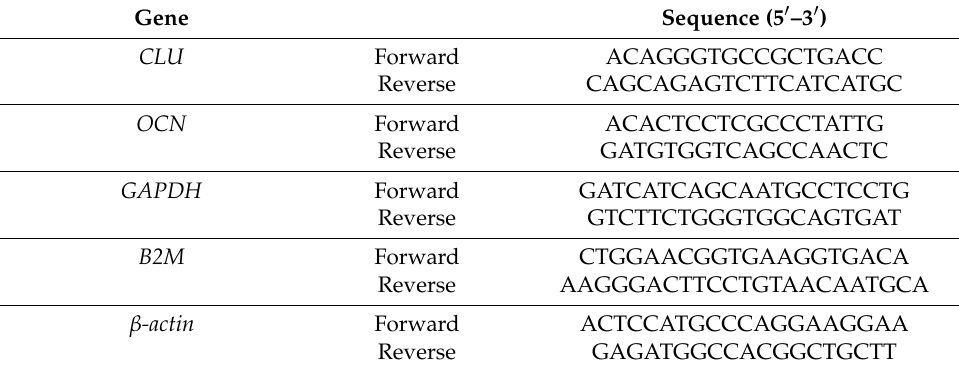
Table 2. qRT-PCR primer